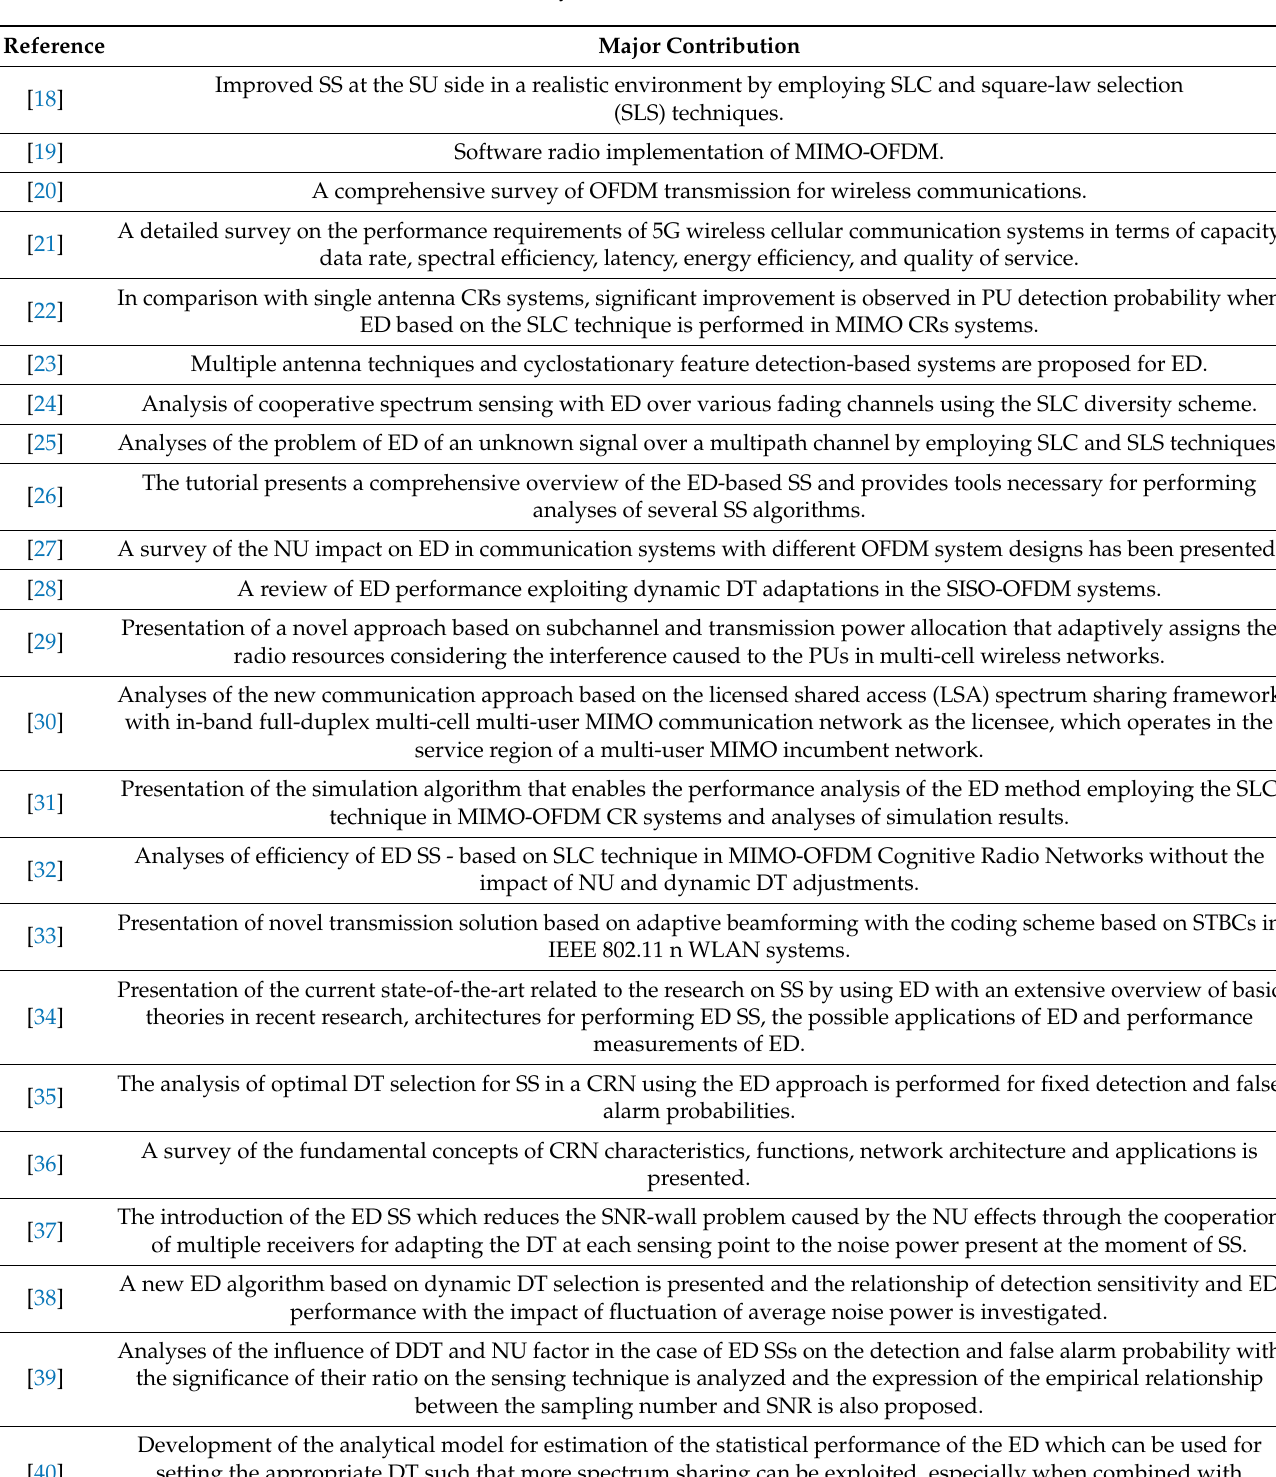
Table 1. Literature survey of related